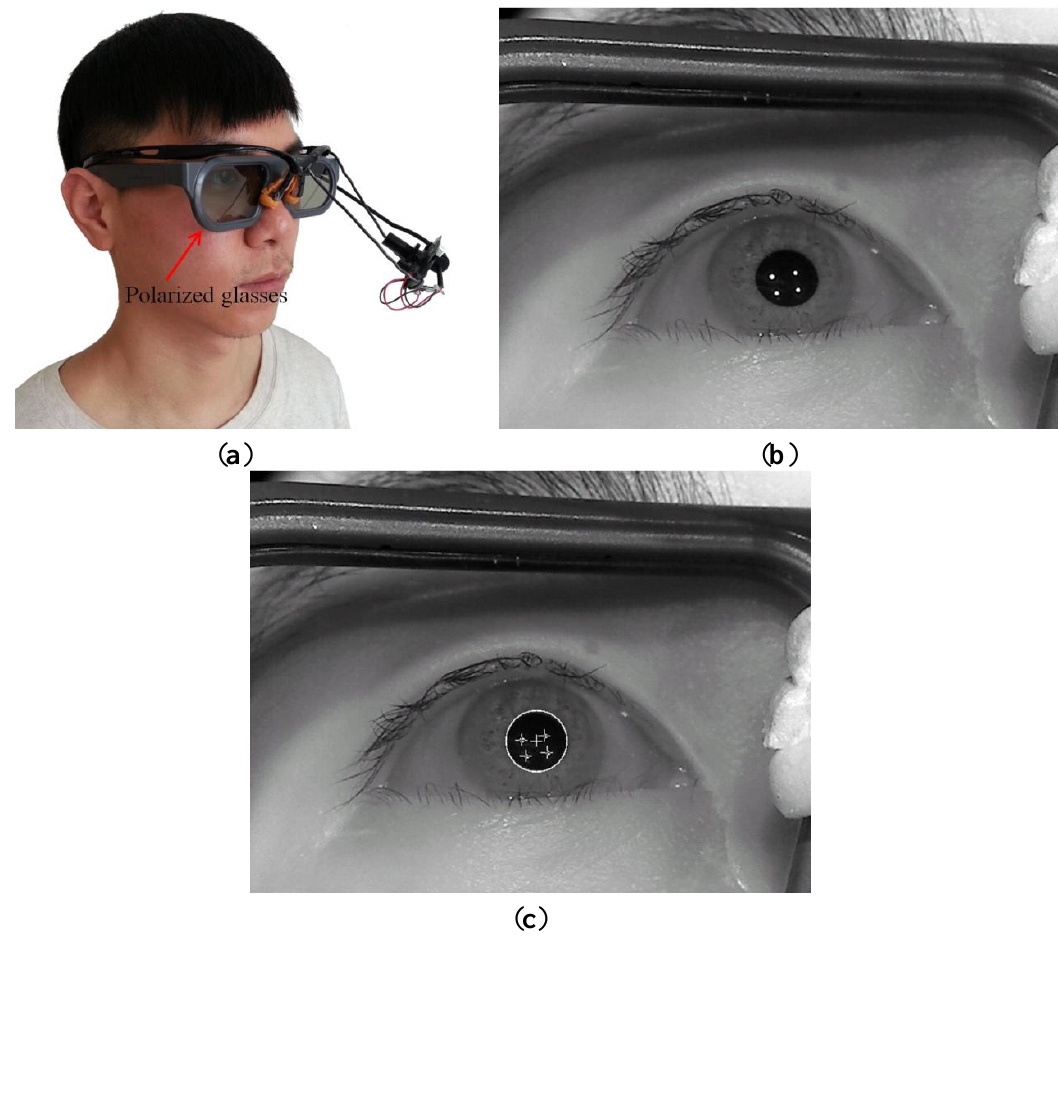
Figure 10. Examples of applying our device and method to the polarized glasses for 3D stereoscopic display: ( a ) the case of using our device with polarized glasses for 3D stereoscopic display; ( b ) the captured eye image; ( c ) the resulting image from successfully detecting the pupil center with four SR